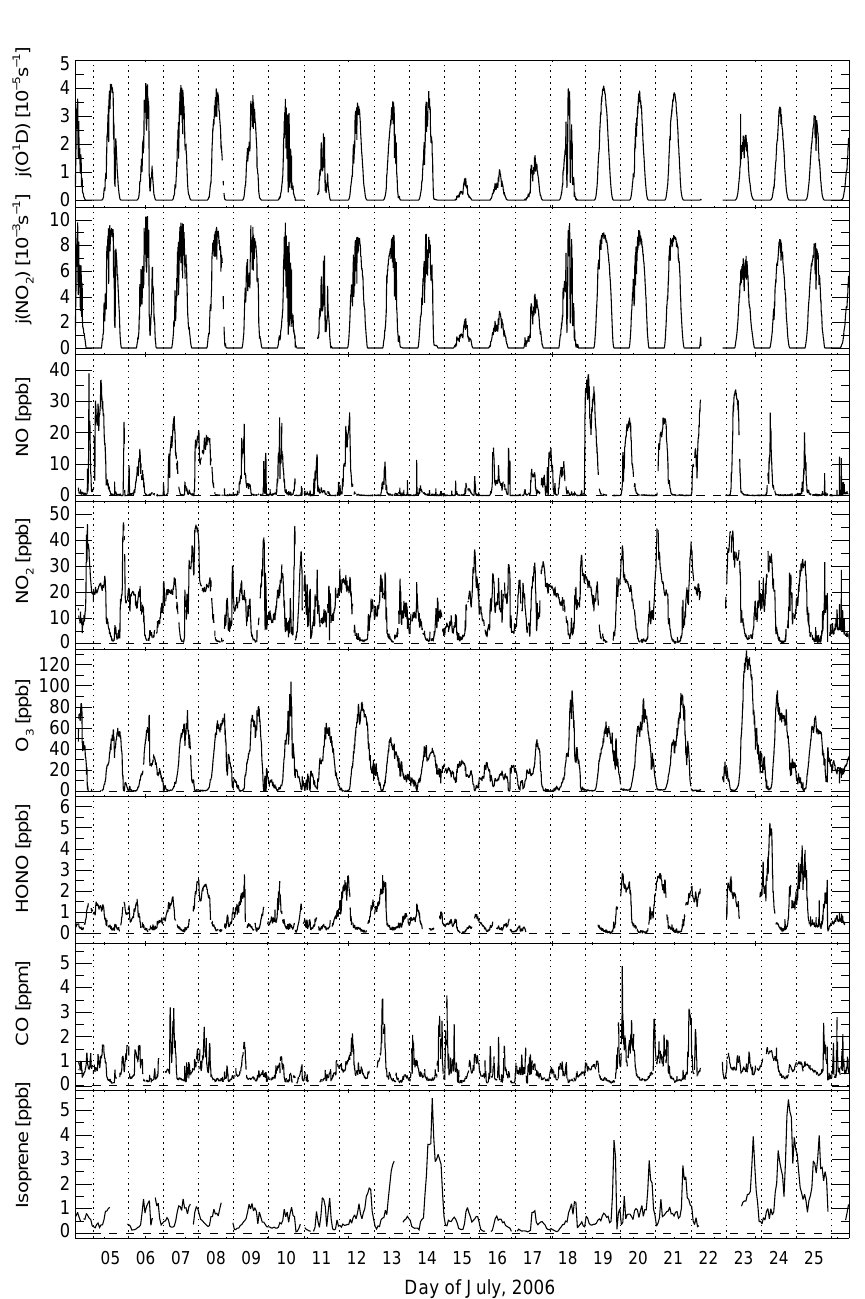
Fig. 5. Time-series of measured j( O 1 D ) , j( NO 2 ) , NO, NO 2 , O 3 , HONO, CO and isoprene at PRD Backgarden from 5 July to 25 July 2006. Vertical lines denote midnight.